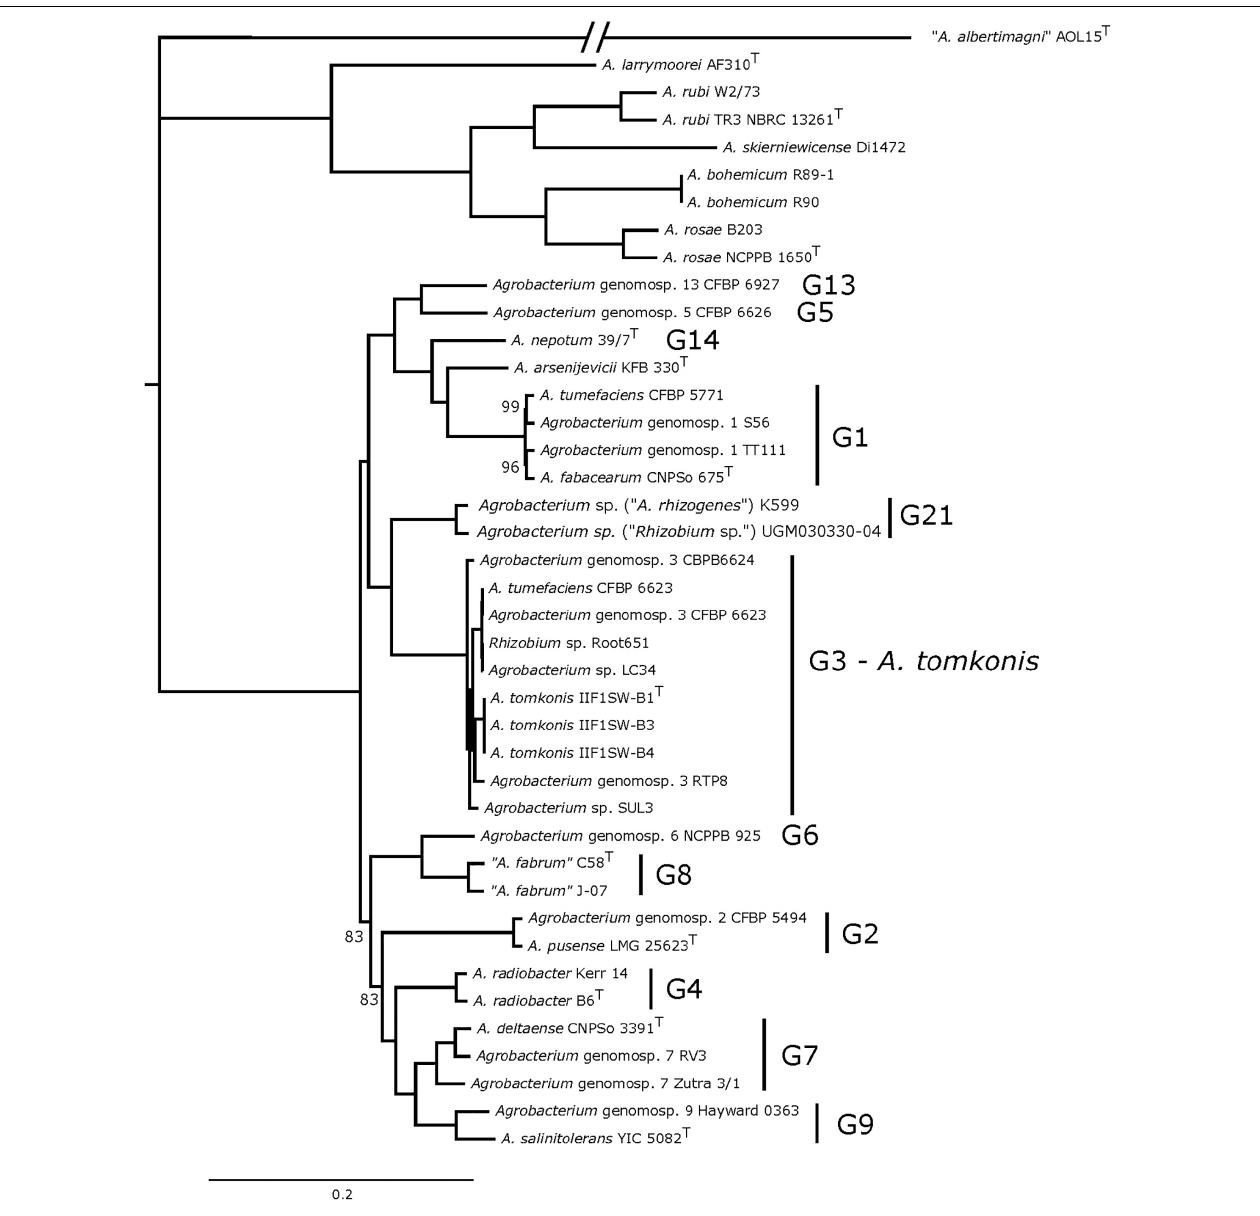
FIGURE 2 | Phylogeny of 40 Agrobacterium spp. strains based on the concatenation of 1,089 core-genome genes. Maximum-likelihood phylogenetic tree of 40 Agrobacterium distinct strains (41 when including the two published genome versions for strain CFBP 6623) obtained using the bioinformatic pipeline Pantagruel (data available at https://doi.org/10.6084/m9.figshare.14792178). The tree was computed with RAxML 8.1.2 based on the concatenation of 1,089 core-genome gene alignments under the GTRCATX model, with 200 rapid bootstraps and rooted with RAxML tree-balance algorithm. All branch supports are 100%, unless